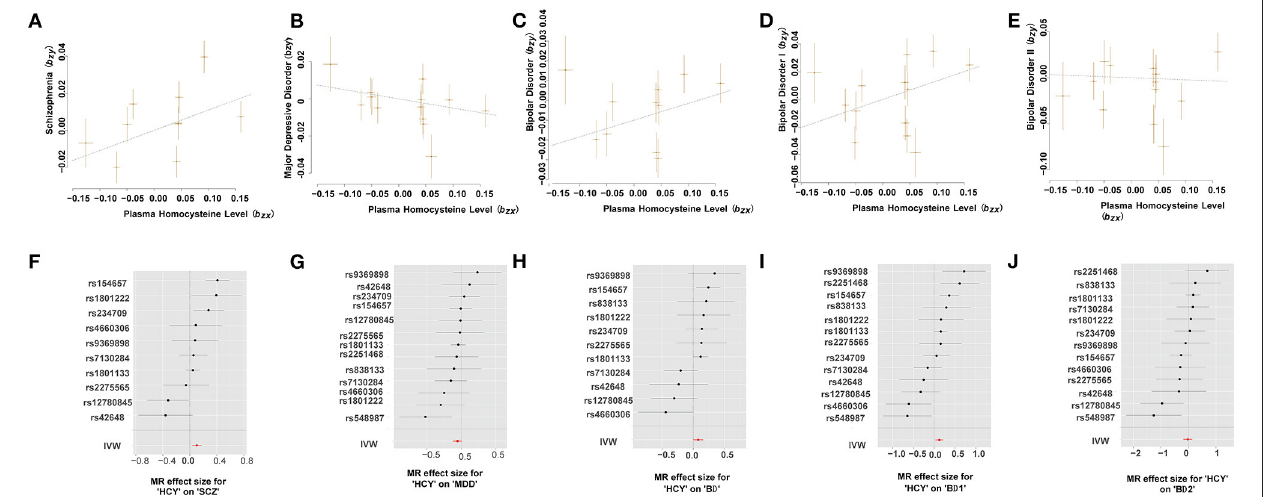
FIGURE 2 | Mendelian randomization plots for relationship of Hcy level with MPDs. (A–E) Scatter plot of SNP potential effects on Hcy on SCZ (A) , MDD (B) , BD (C) , BD-I (D) , and BD-II (E) , with the slope of each line corresponding to estimated MR effect per method. (F–J) Forest plot of individual and combined SNP MR-estimated effects sizes for relationship of Hcy level with SCZ (F) , MDD (G) , BD (H) , BD-I (I) , and BD-II (J) . Data are expressed as beta values with 95% CI. IVW indicates inverse variance96weighted method.